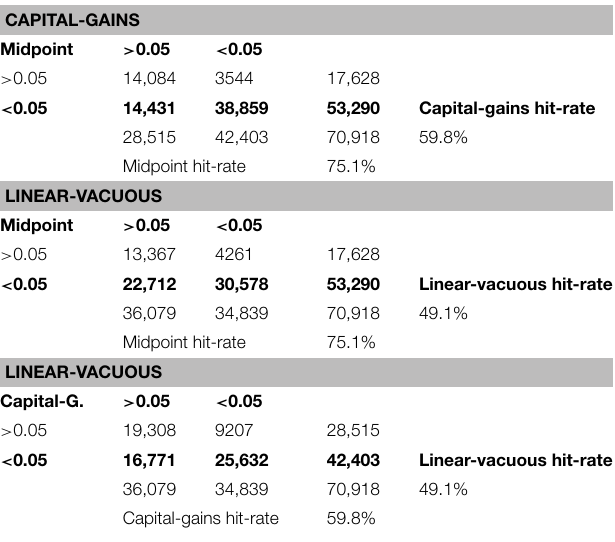
TABLE 1 | Three models’